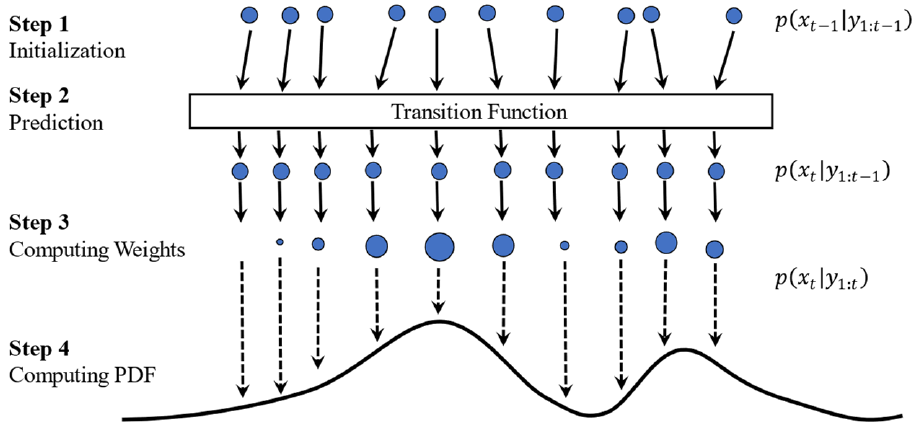
Figure 4. Steps associated with a Particle Filter approach. (1) Particle initialization; (2) prediction; (3) computing weights; and (4) computing PDF. Steps 3–4 are collectively known as the update phase.